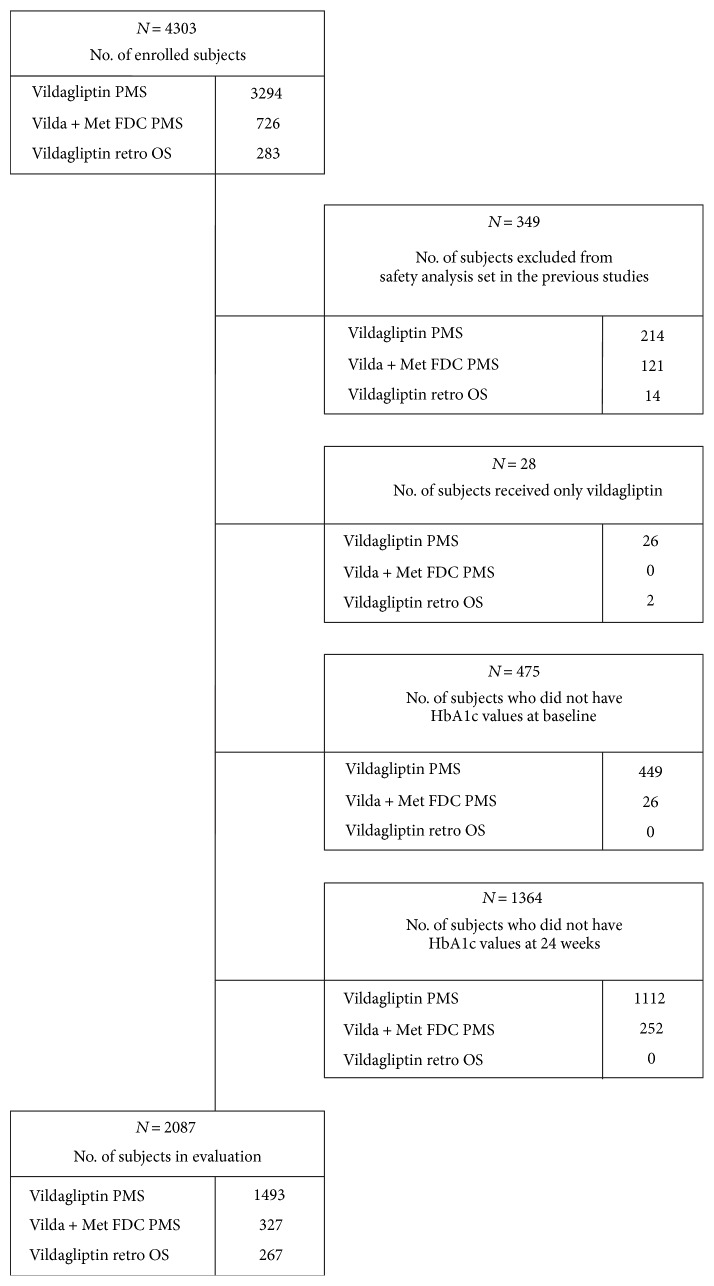
Flow diagrams of patient disposition. PMS: postmarketing survey; retro OS: retrospective observational study.